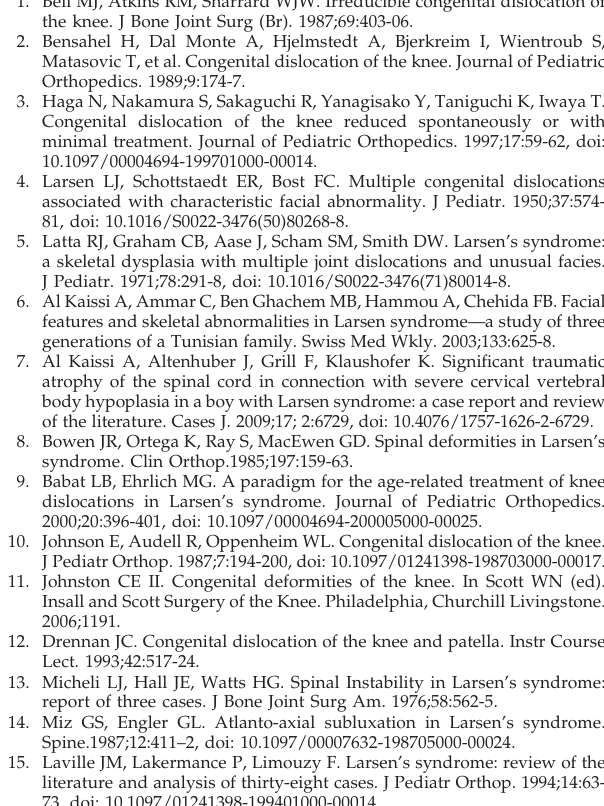
Figure 6 - Orthotic